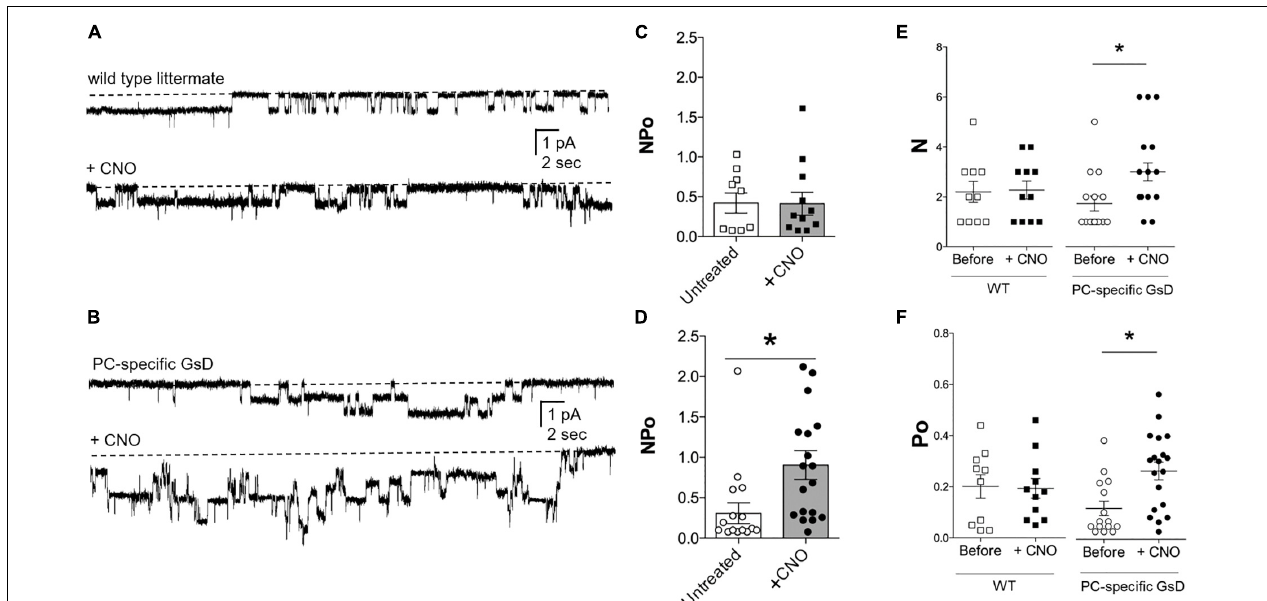
FIGURE 3 | CNO increases ENaC activity in PC-specific GsD mice. Representative gap-free current traces of ENaC in cell-attached patch clamp recordings of the apical membranes of PCs in isolated tubules from wild type littermates (A) and PC-specific GsD (B) mice in the absence (top) and presence (bottom) of pre-treating tubules with CNO (2 µ g/ml, 30 min). Inward Na + current is downwards with dashed lines indicating the closed state. Summary graphs of ENaC activity (NP o ) in PCs in tubules isolated from wild type controls (C) without (white boxes, n = 9 patches from 3 distinct mice) and with CNO (black boxes; n = 11 patches from 3 distinct mice), and from PC-specific GsD mice (D) without (white circles, n = 15 patches from 3 distinct mice) and with CNO (black circles, n = 18 patches from 3 distinct mice). * P < 0.05 vs. no CNO treatment. Summary graphs of ENaC N (E) and P o (F) in PCs in tubules isolated from wild type controls (white boxes, n = 10 from 3 distinct mice) and after CNO (black boxes, n = 10 from 3 distinct mice); and from PC-specific GsD mice before (white circles, n = 13 from 3 distinct mice) and after CNO (black circles, n = 10 from 3 distinct mice). Summary data from experiments identical to those shown in (A,B) . * P < 0.05 vs.